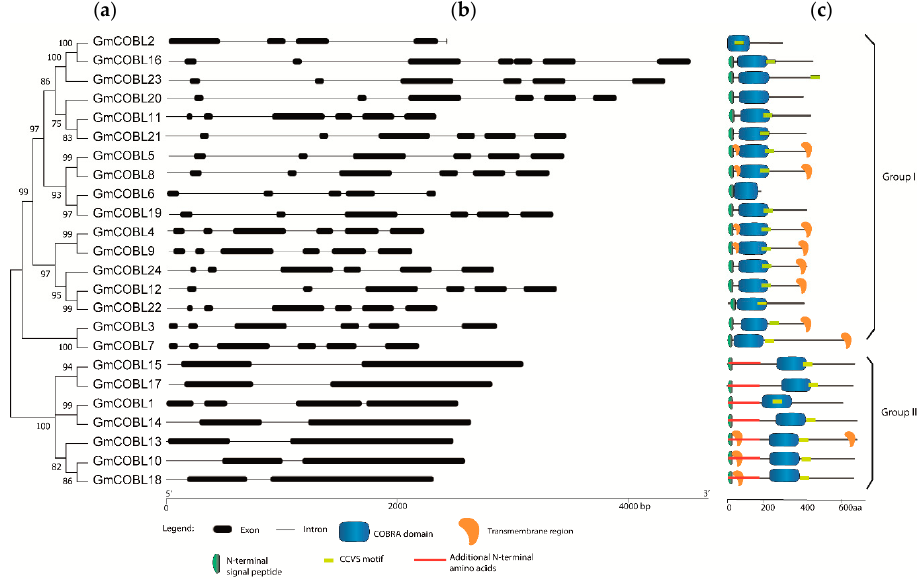
Figure 2. Phylogenetic relationship, gene structure, and domain architecture of GmCOBLs in soybean. ( a ) Phylogenetic relationship of COBL genes identified in soybean. ( b ) Gene structure of the 24 full-length coding COBL sequences in soybean. CDSs are represented with black rectangles and introns with black lines. The length of CDSs and introns can be estimated using the scale shown below. ( c ) Schematic representation of the domain architecture of the full-length COBL proteins. The size of domains can be estimated using the scale shown below.